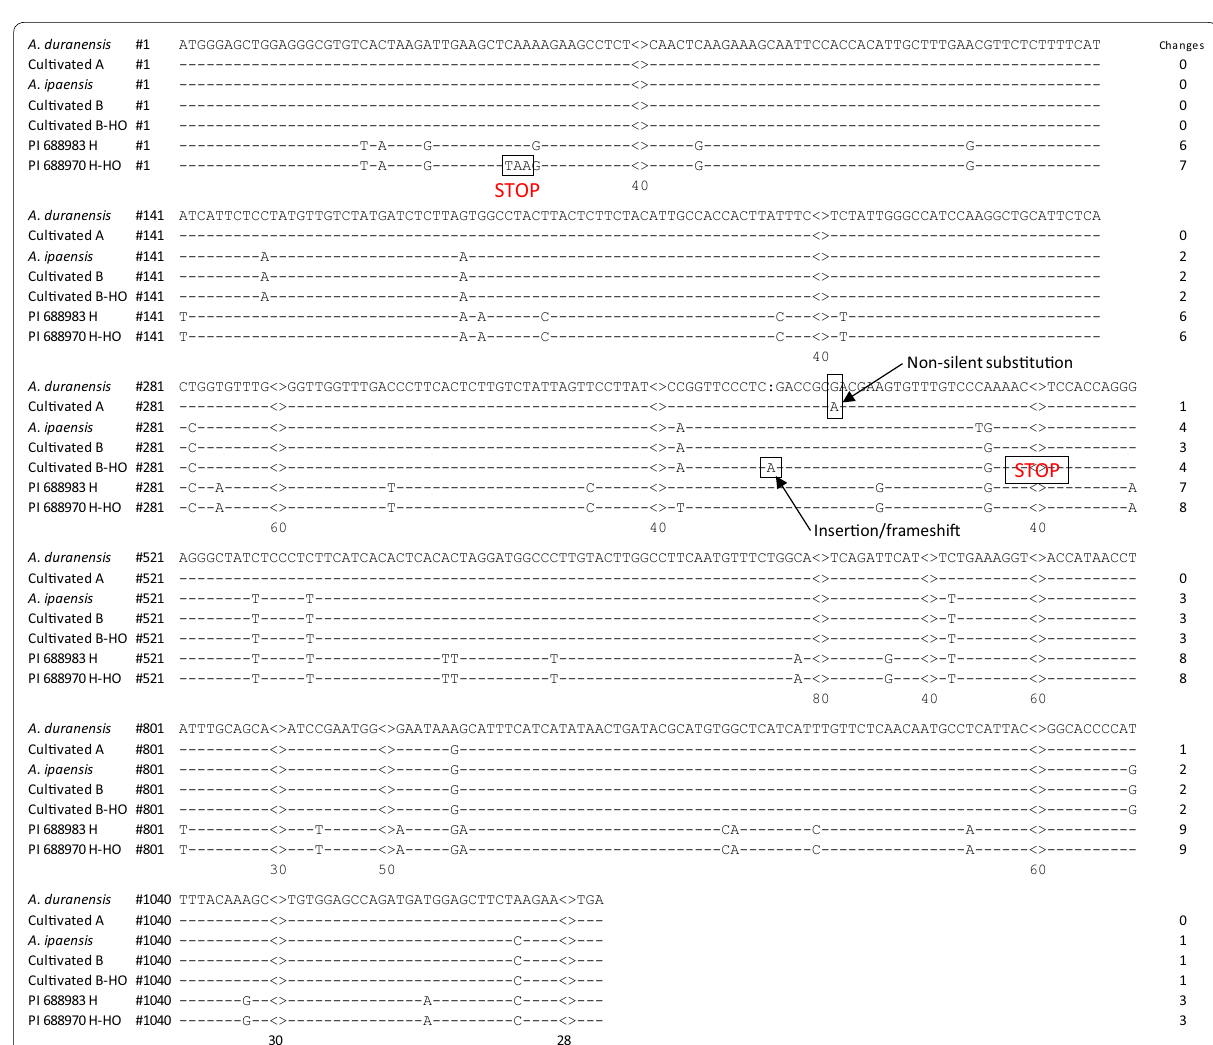
Fig. 2 Comparison of DNA sequences of FAD2 coding region and identification of SNPs among seven genomes from six different lines or accessions. Cultivated A and Cultivated B represent subgenomes A and B from cultivated peanut Tifrunner. Cultivated B-HO represents subgenome B from F435 with high oleic acid trait. “< >” represents omitted stretches with no variation. Black rectangle of A. veigae PI 688970 represents stop codon. There is also a stop codon at position 442 for Cultivated B-HO it is not shown due to the space limitation in the figure. The FAD2 sequences of A. duranesis and A. ipaënsis were downloaded from the public